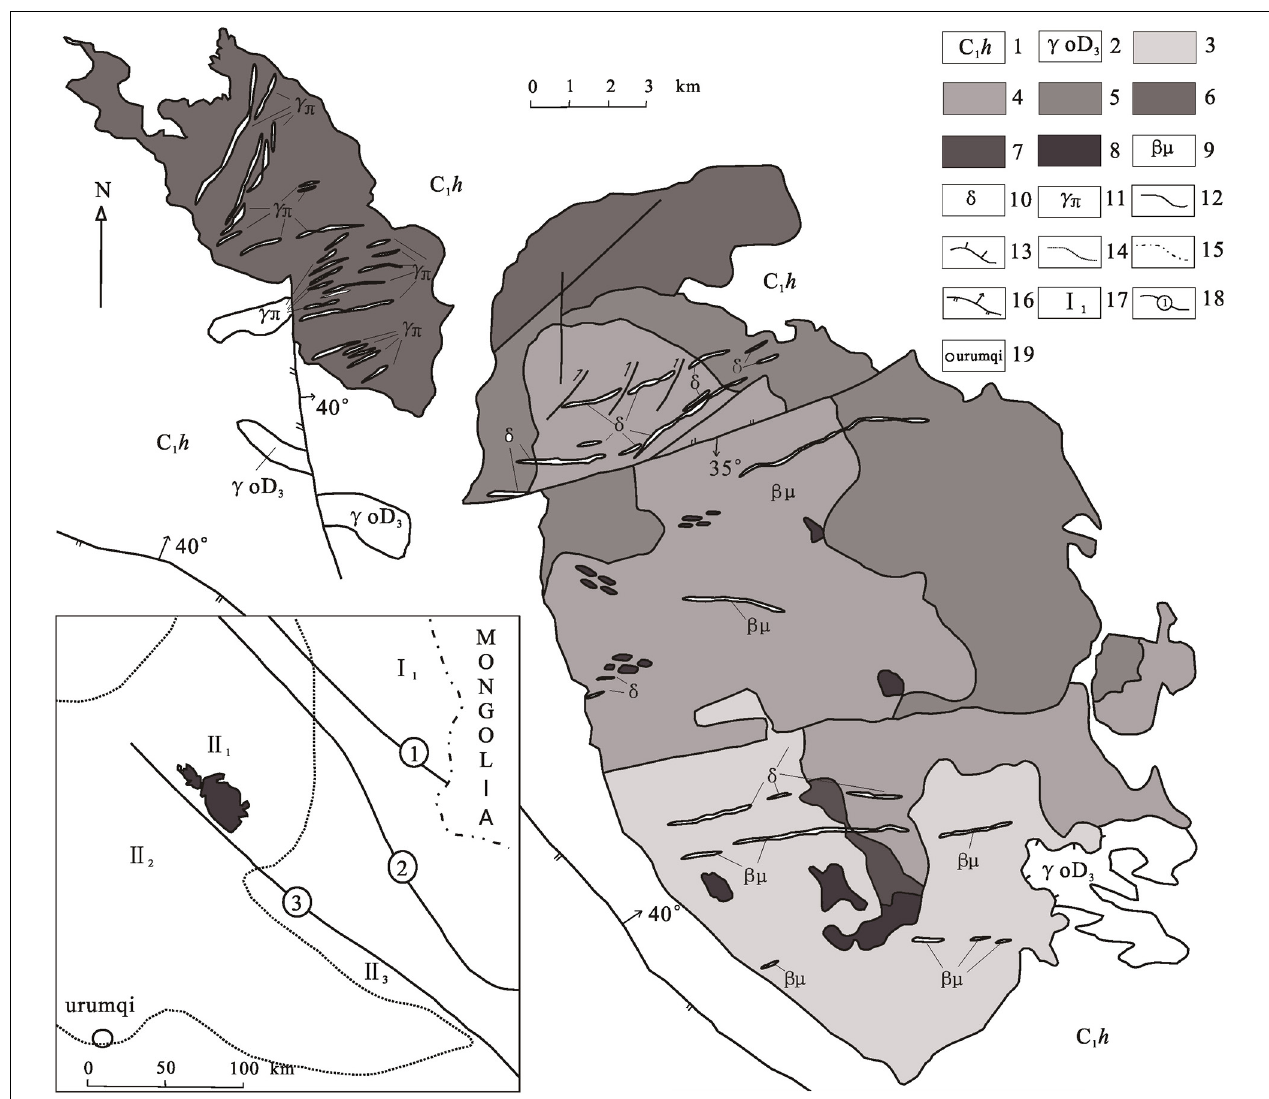
FIGURE 1 | Geological map of the Huangyangshan pluton (adapted from Yang et al., 2011). 1-Heshanshitou Group; 2-plagioclase granite; 3-medium grained biotite alkali feldspar granite; 4-medium grained hornblende alkali feldspar granite; 5-medium grained arfvedsonite alkali feldspar granite; 6-medium to fine grained arfvedsonite alkali feldspar granite; 7-fine grained biotite alkali feldspar granite; 8-fine grained mixed granite; 9-diabase dyke; 10-diorite dyke; 11-granite porphyry dyke; 12-pulsating contact; 13-beveling contact; 14-intrusive contact; 15-structural belt boundary; 16-fault and occurrence; 17 and 18-number of structure belt; I 1 -Altai structure belt; I 2 -Almantai structure belt; II 1 -Kalamali structure belt; II 2 -Junggar Basin; II 3 -Jiangjunmiao structure belt: (cid:172) Irtysh Fault; (cid:173) Almantai Fault; (cid:174) Kalamaili